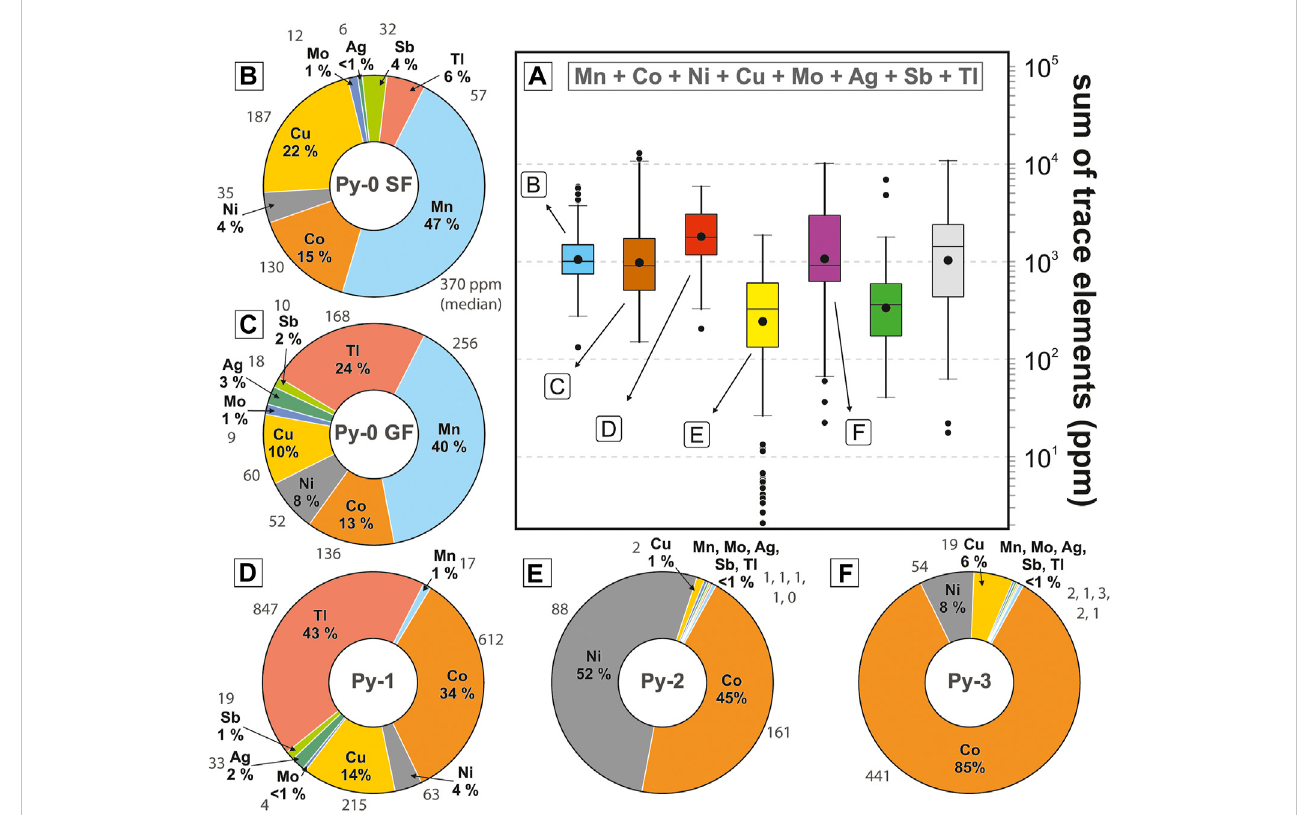
FIGURE 9 (A) The summedabundanceofminor traceelements (Mn,Co,Ni,Cu, Mo,Ag,Sb,and Tl;Zn, As,andPbexcluded).Fordetailsofthestatisticalmethodfor box and whisker plots see Figure 8. (B – F) Relative proportions of individual trace elements (median abundances in percent) for individual pyrite sub-types; grey values denote respective median trace element abundances in ppm.